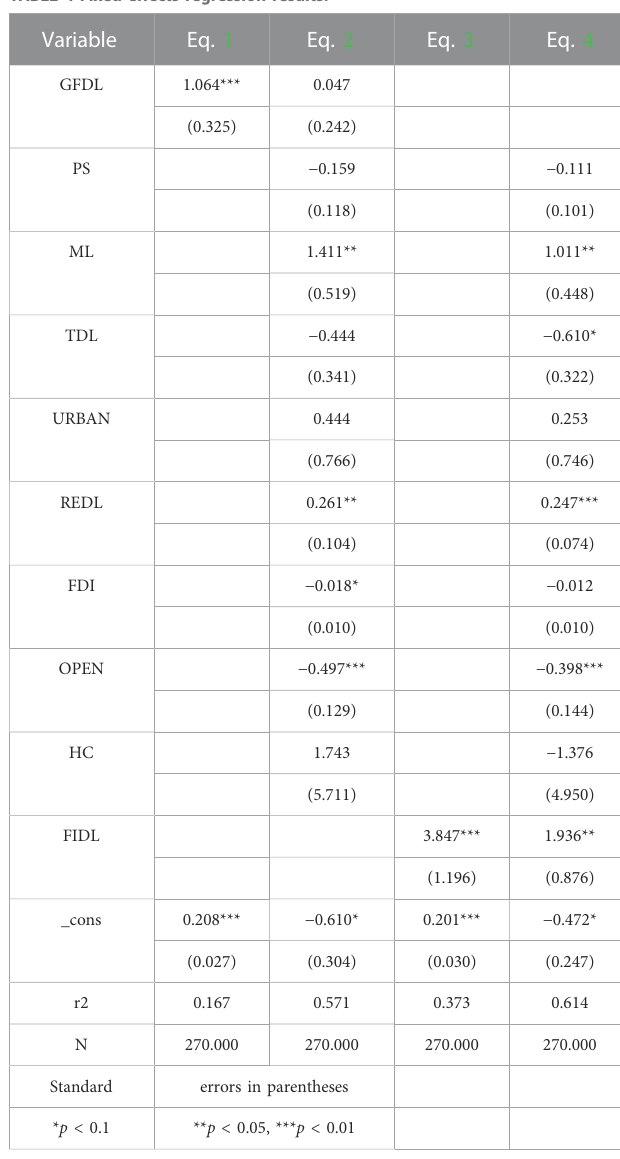
TABLE 4 Fixed effects regression